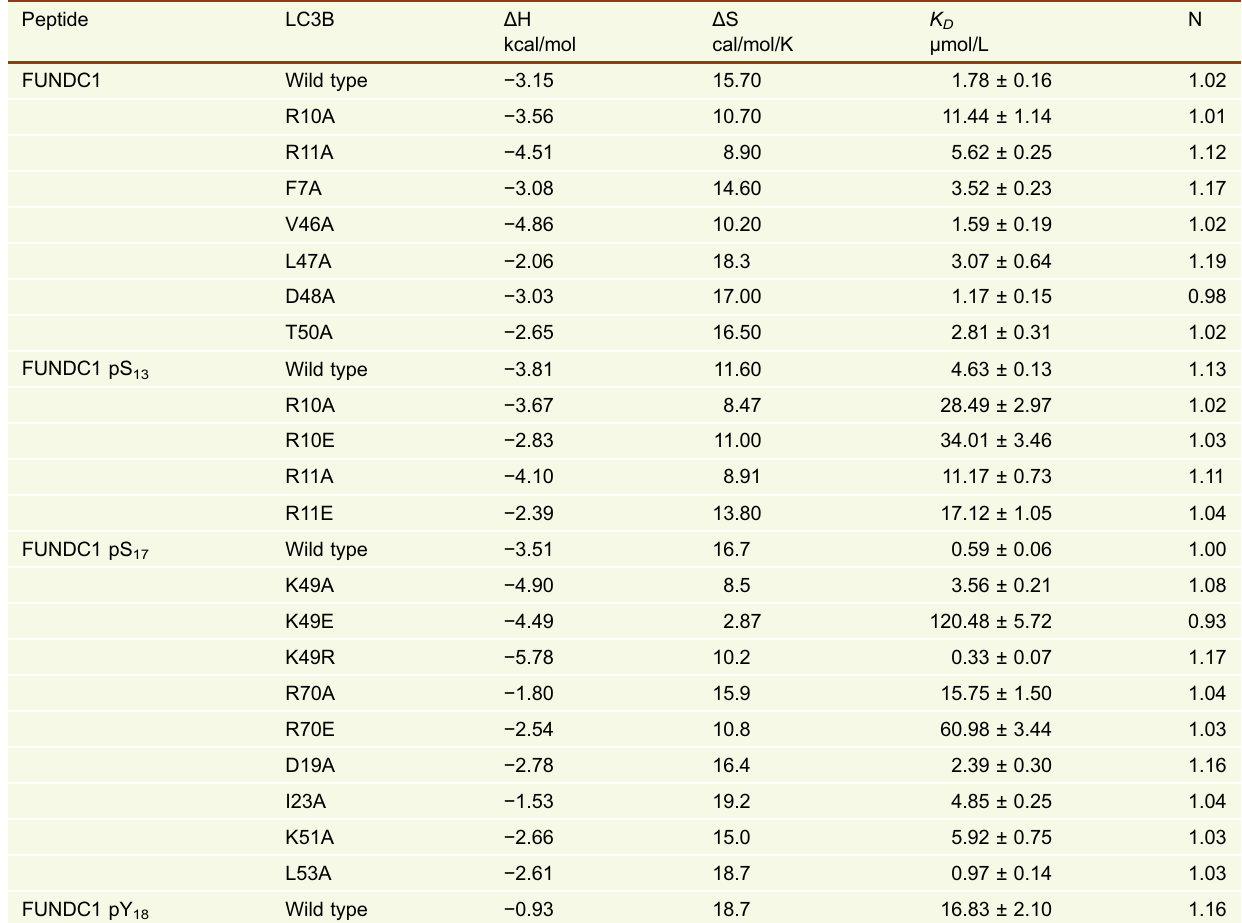
Table 2. The thermodynamic parameters of the ITC experiments